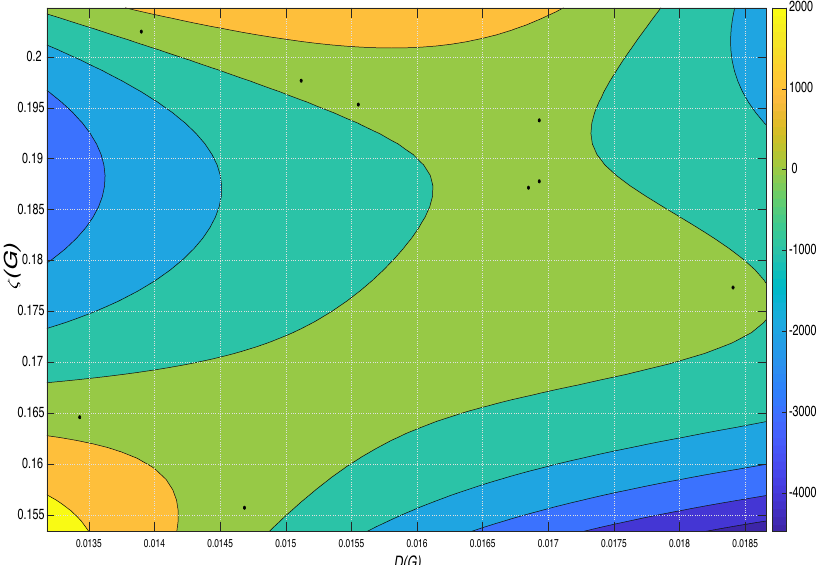
Figure 4. Shows the contour plot of D ( G ) and ζ( G ) .